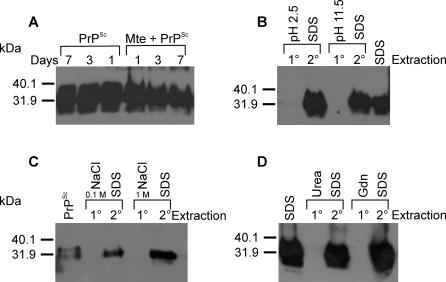
PrPSc Adsorbed to Mte Avidly and Remained Stable(A) PrPSc was stable when adsorbed to Mte for at least 7 d. (B) Extremes in pH (100 mM phosphate at pH 2.5 or 11.5), (C) sodium chloride (100 mM or 1 M), and (D) chaotropic agents (8 M urea or 8 M guanidine [Gdn]) did not desorb detectable amounts of PrPSc from Mte. Primary extractions (1°) were followed by secondary extractions (2°) extractions with a 10% SDS solution at 100°C. Immunoblots (A–D) employed mAb 3F4. Pel, PrPSc associated with pelleted mineral particles; Sup, unbound PrPSc in supernatant.